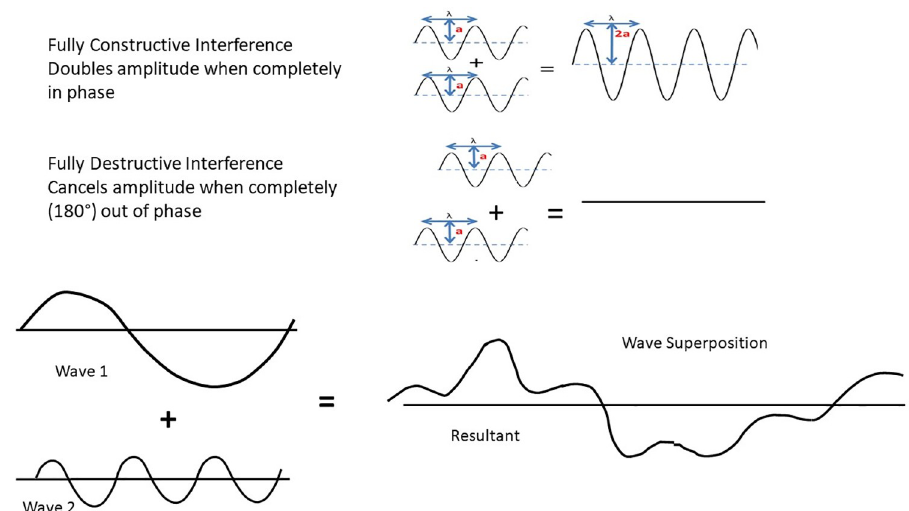
Fig 3. Wave interference diagrams. Two equal wavelengths of equal amplitude, will either double the amplitude during fully constructive interference when they are exactly in phase or completely cancel during fully destructive interference when exactly out of phase. Superposition of non-identical waves exhibits irregular patterns integrating both constructive and destructive interference.